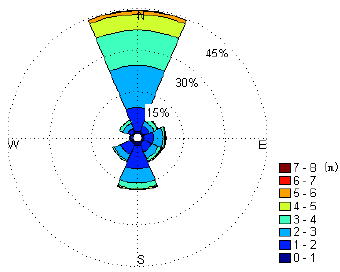
Figure 5. The rose plot of independent samples from 1990 to 2011 at location S1.